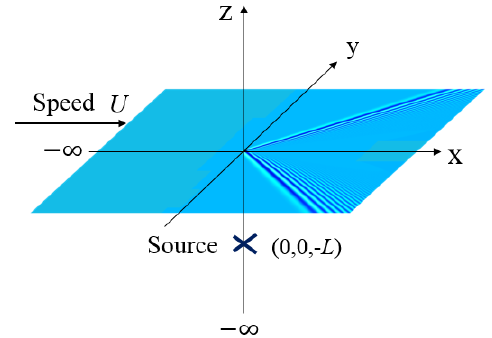
Figure 1. Illustration of the disposition about the fluid.